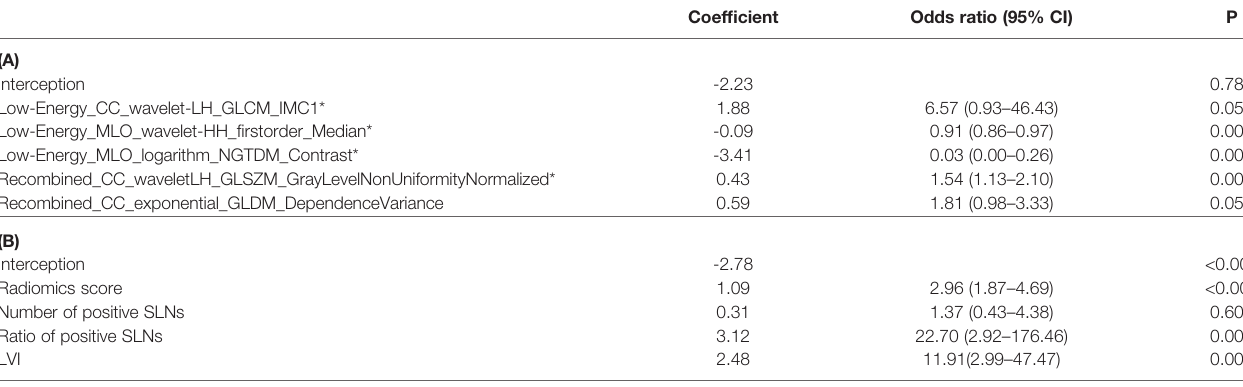
TABLE 3 | The corresponding coef fi cients for establishing the radiomics score (A) and radiomics model (B).